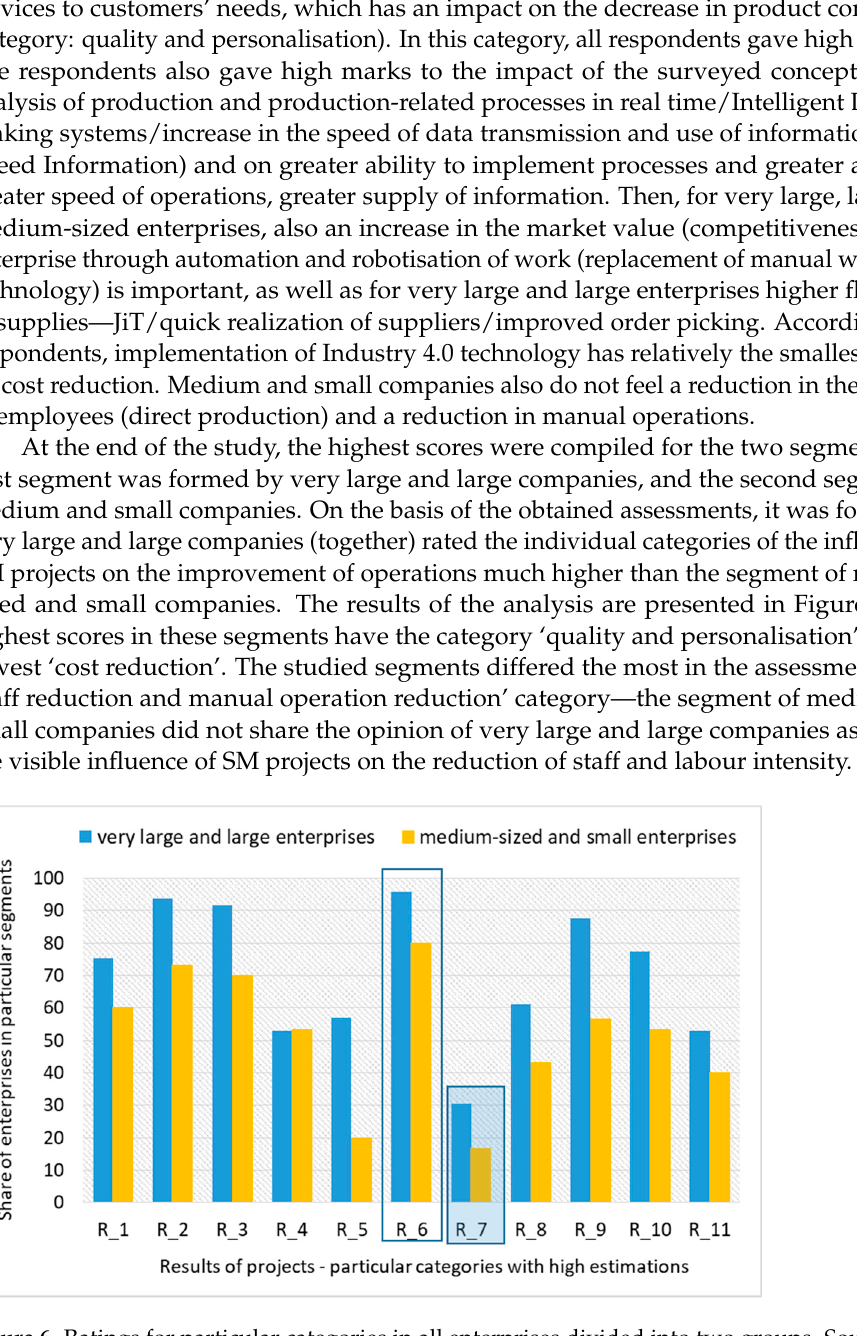
Figure 6. Ratings for particular categories in all enterprises divided into two groups. Source: own research